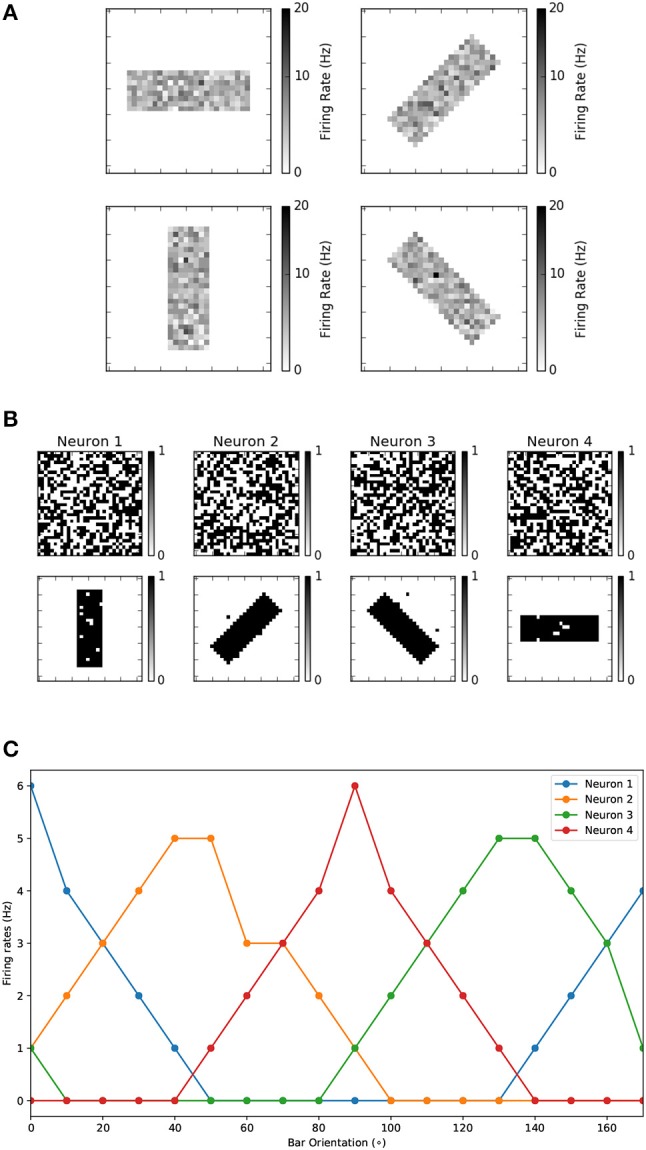
(A) The input pattern used for the orientation selectivity experiment. During the experiments the bar is presented in random order. (B) The initial and final 1-bit weights for the development of orientation selectivity experiment. (C) Orientation tuning curves obtained by rotating a horizontal bar counter clockwise with a step size of 10°C.